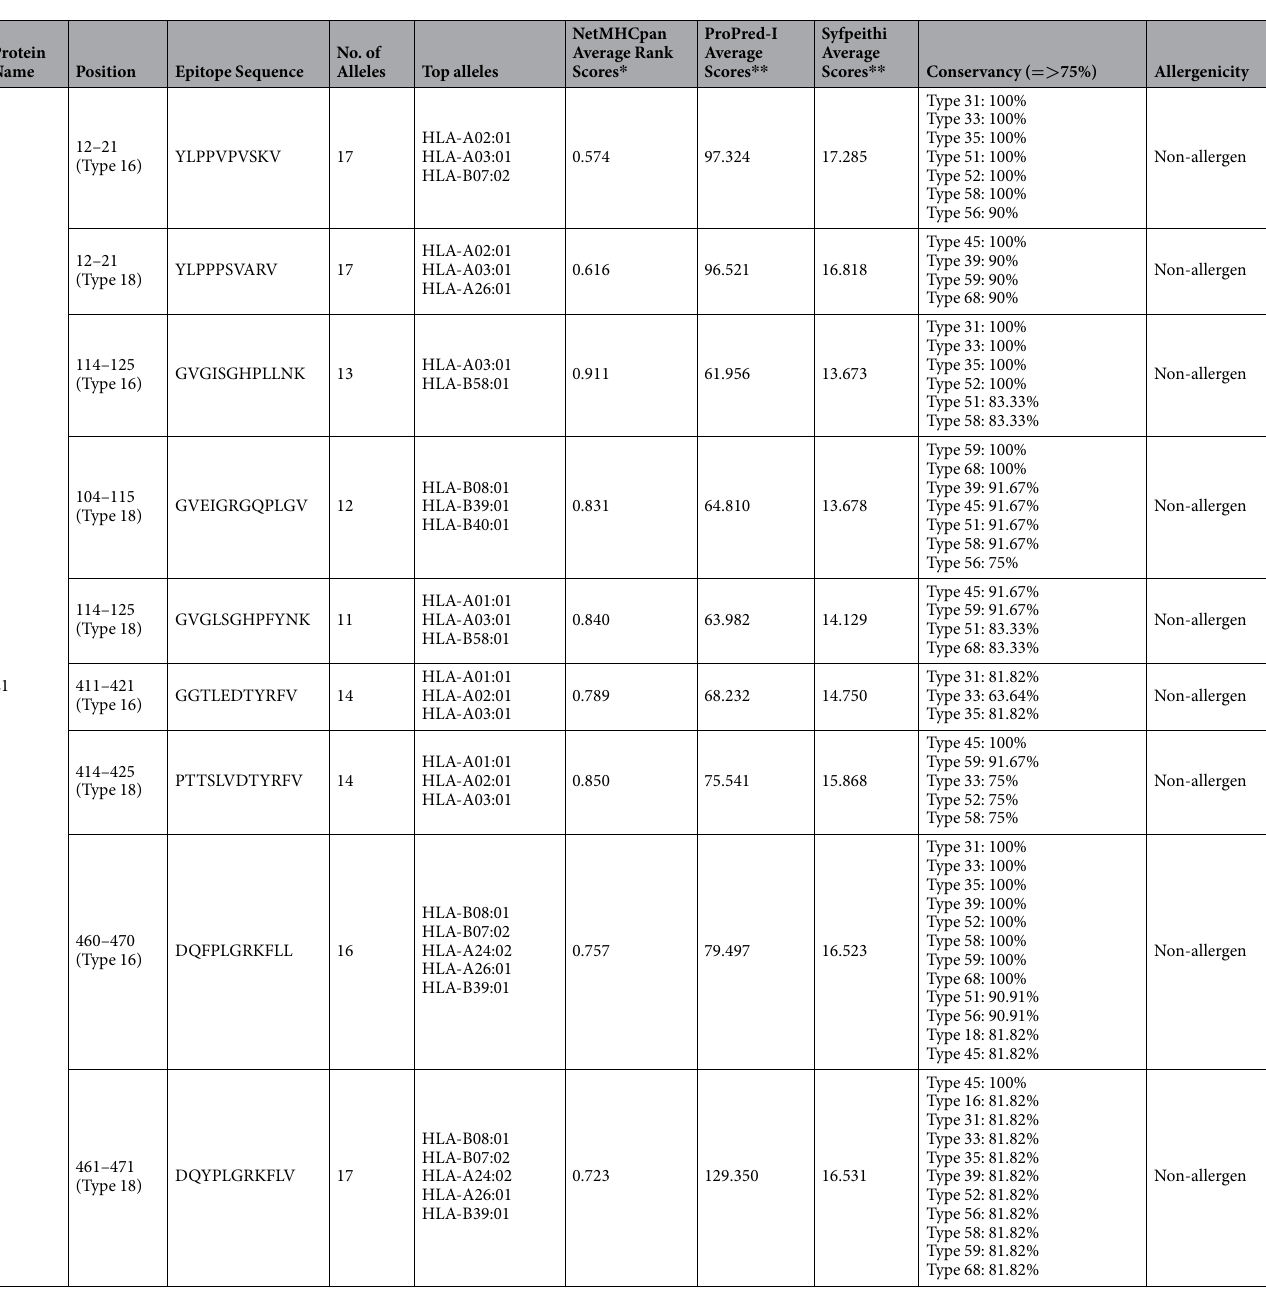
Table 4. The selected CTL epitopes of HPV L1 protein based on binding affinity. * lower rates show better binding affinity, ** Higher rates show better binding